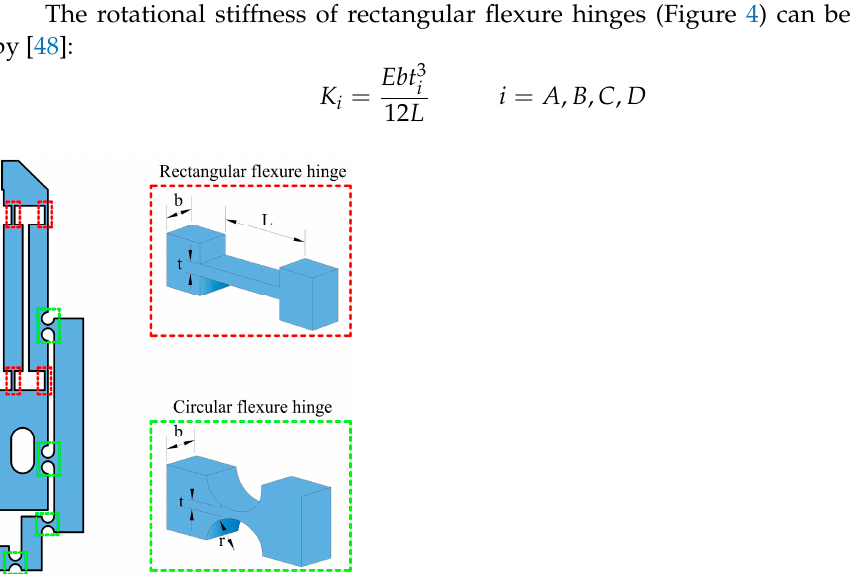
Figure 4. Rectangular and circular flexible hinges implemented in the MG design.